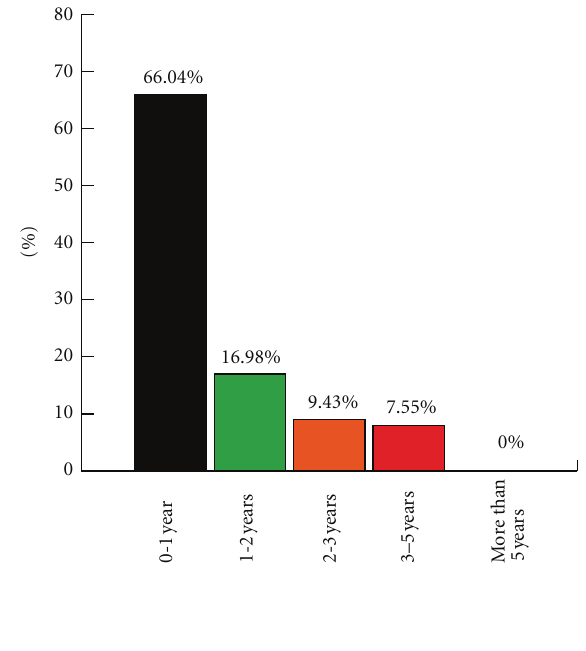
Figure 1: Failures distribution over